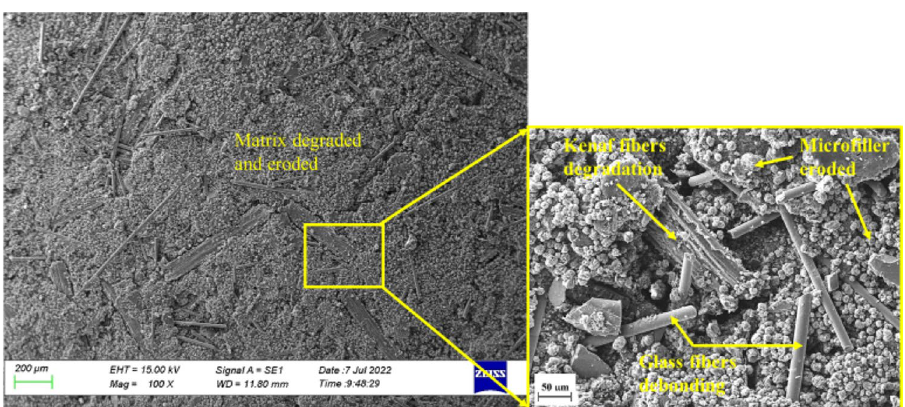
Figure 14. Scanning electron micrographs of the surface of the MCC0 composite post-immersion in the acidic